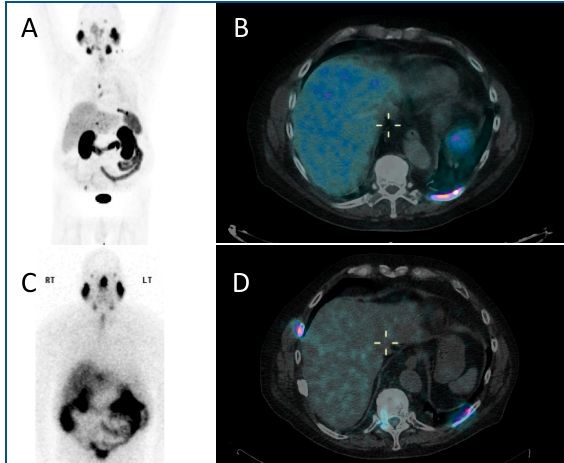
Figure 2. A PMSA-based theragnostic approach to metastatic prostate cancer. ( A ) Anterior view of maximum intensity projection, and ( B ) axial view of 68 Ga-PMSA PET CT (positron emission tomography, computed tomography) demonstrating left posterior rib metastasis. Then, following 177 Lu PMSA administration, ( C ) anterior view planar scintigraphy and ( D ) SPECT CT (single photon emission computed tomography, computed tomography) imaging. While these show similar appearances, post-therapy imaging has a lower resolution as the techniques are different.